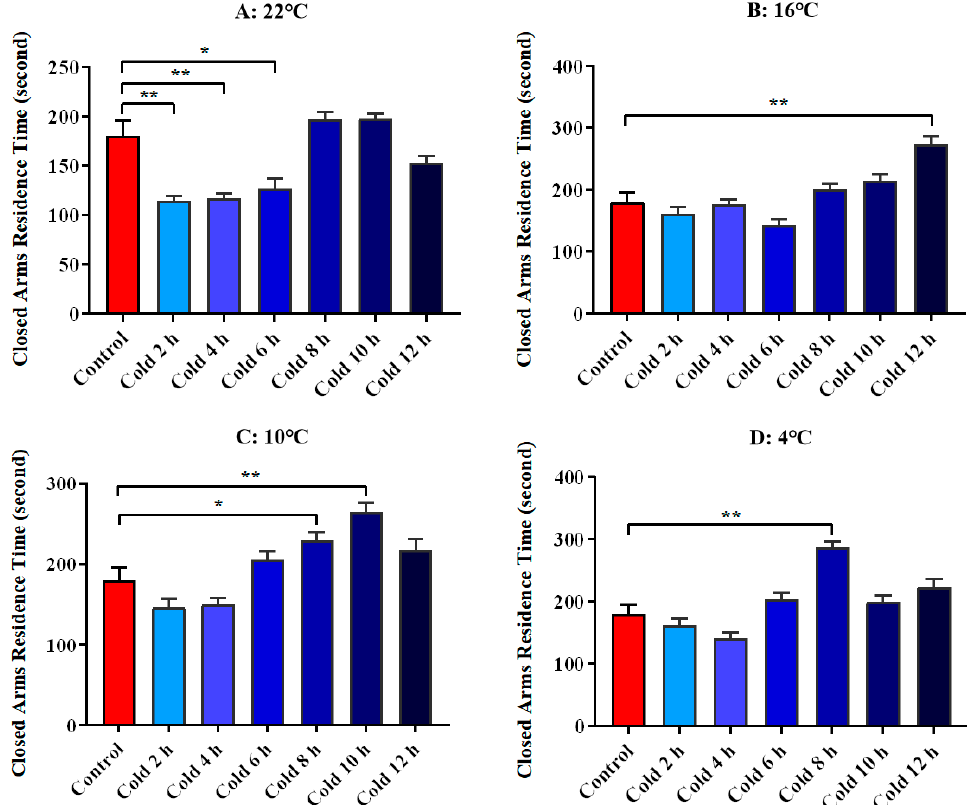
Figure 6. Changes in anxious mood of ICR mice under different intensity of cold exposure. ( A ). Changes in the closed arms residence time of mice under cold exposure at 22 ◦ C; ( B ). Changes in the closed arms residence time of mice under cold exposure at 16 ◦ C; ( C ). Changes in the closed arms residence time of mice under cold exposure at 10 ◦ C; ( D ). Change in the closed arms residence time of mice under cold exposure at 4 ◦ C. Compared with 28 ◦ C normal temperature control group, the difference was significant as * p < 0.05. ** p < 0.01.